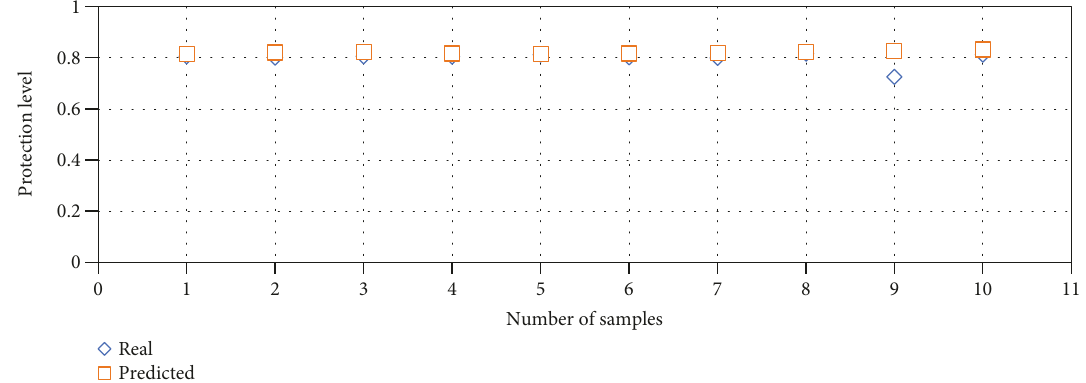
Figure 4: Comparison of the forecast and actual protection level of the